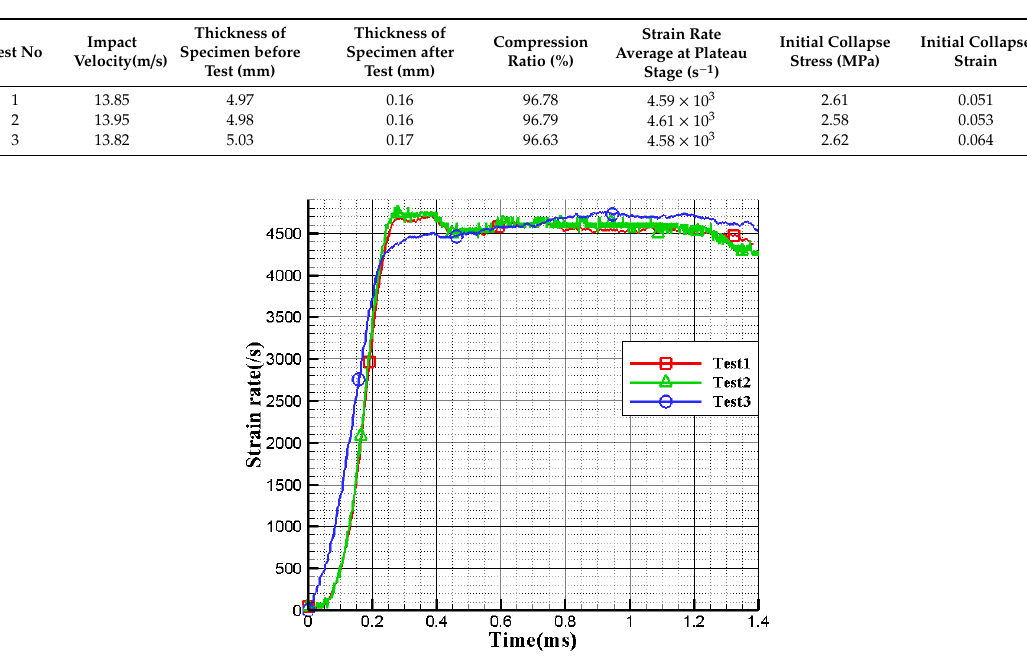
Figure 12. Stress–strain curve at strain rate 2.0 × 10 3 s - − 1 .